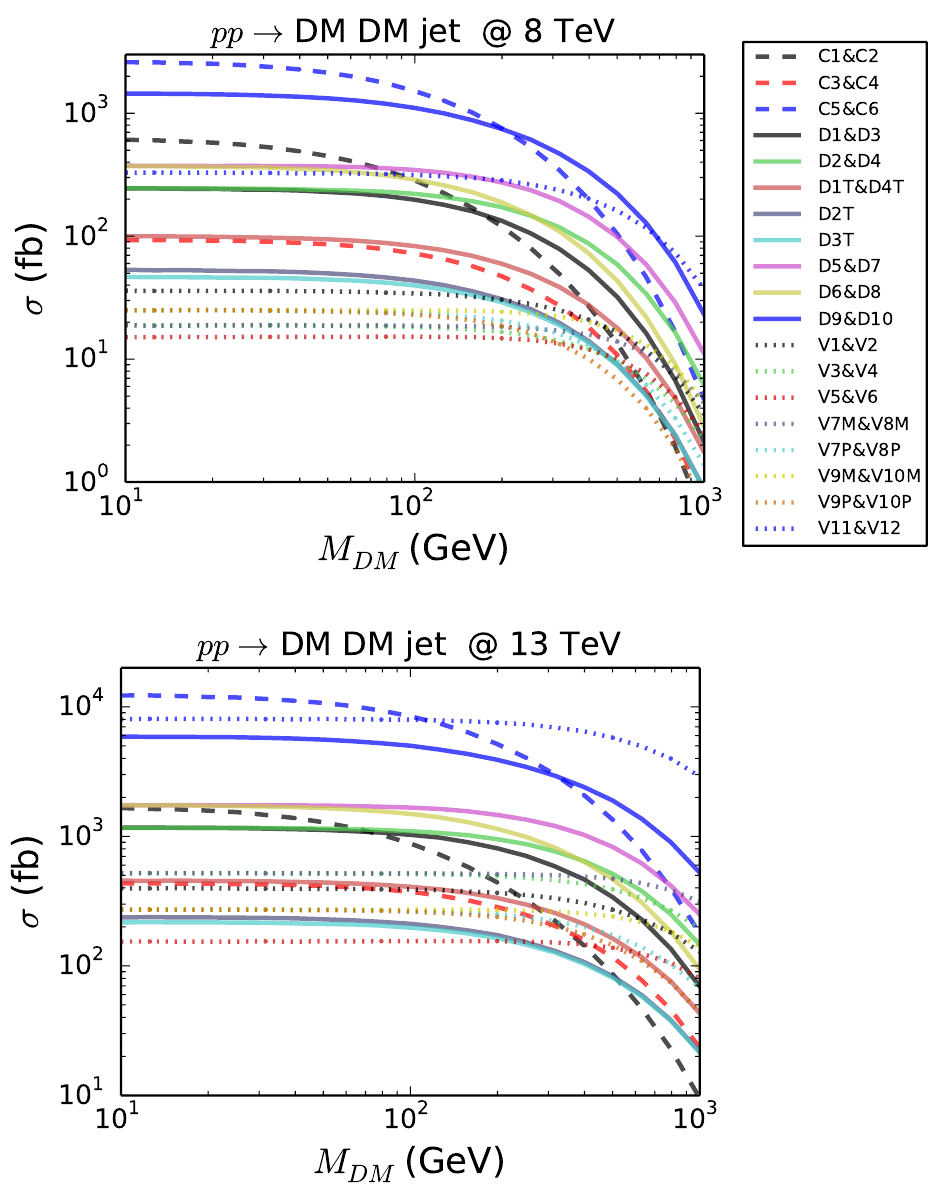
Figure 8 . Mono-jet cross-sections in fb for the EFT operators at 8 TeV and 13 TeV versus DM mass for (cid:3) = 1 TeV for all operators, presented in table 4 From (cid:12)gure 9 one can see that for M between about 0.5 and 1. TeV for all operators. For the (cid:3) V operators are enhanced DM